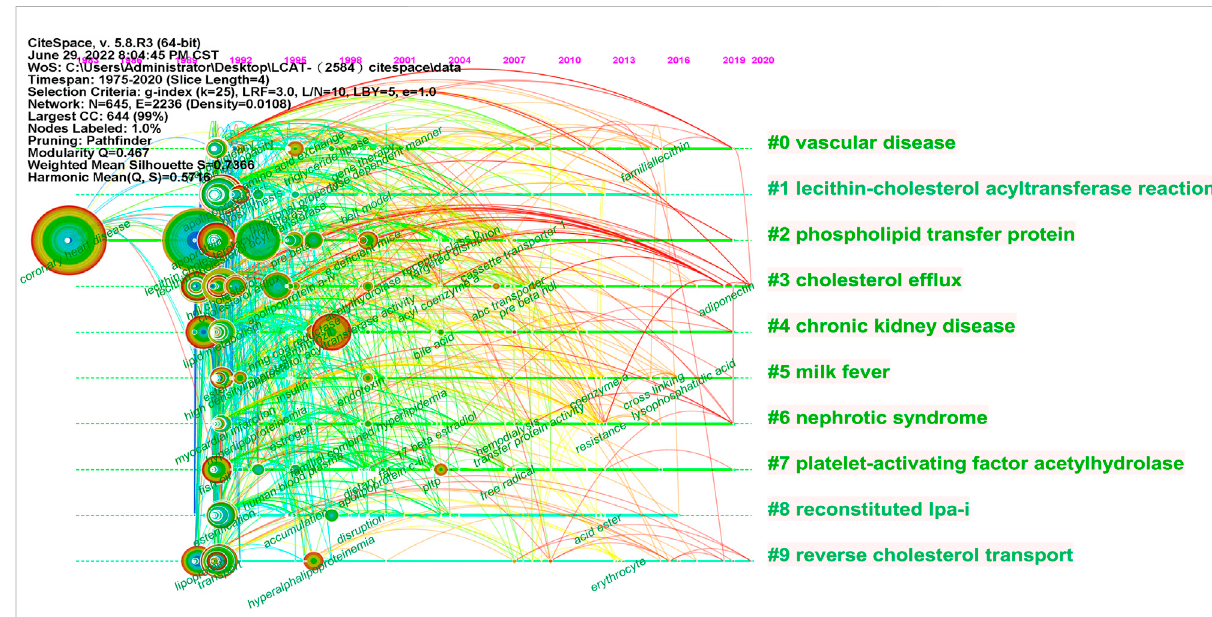
FIGURE 10 ThetimelinemapofLCAT-relatedco-citationclusters.Majorclustersarelabeledontheright.Landmarkkeywords